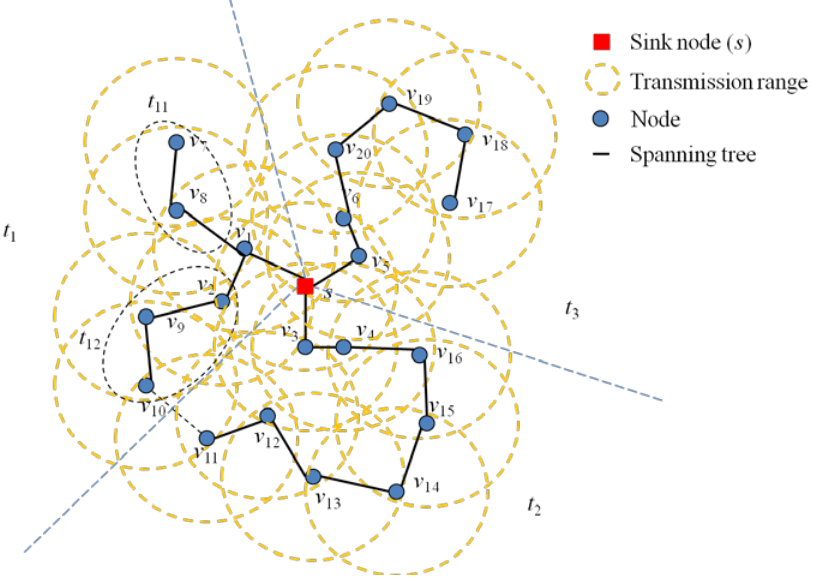
Figure 4. Constructing the minimum spanning trees for nodes in the node set ( Ns ) using the FMLSP